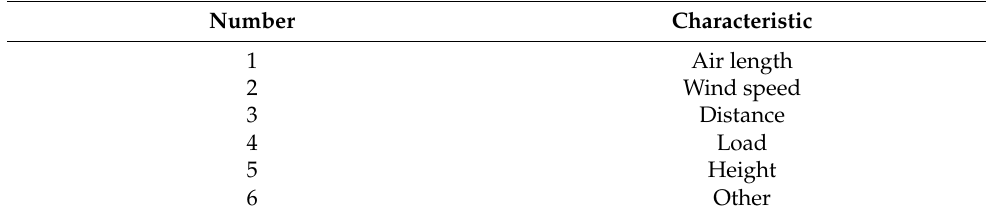
Table 1. Six input characteristic quantities.